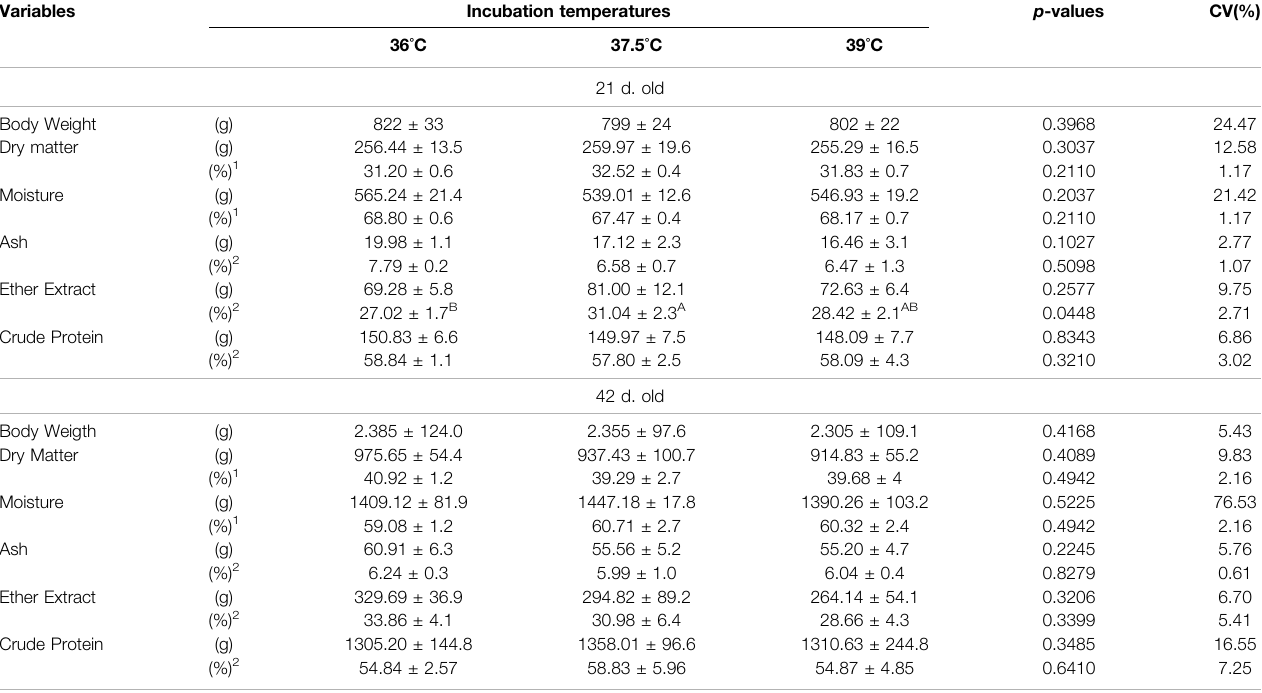
TABLE 5 | Body weight and composition of male broilers at day 21 and 42 of age, according to incubation temperature.